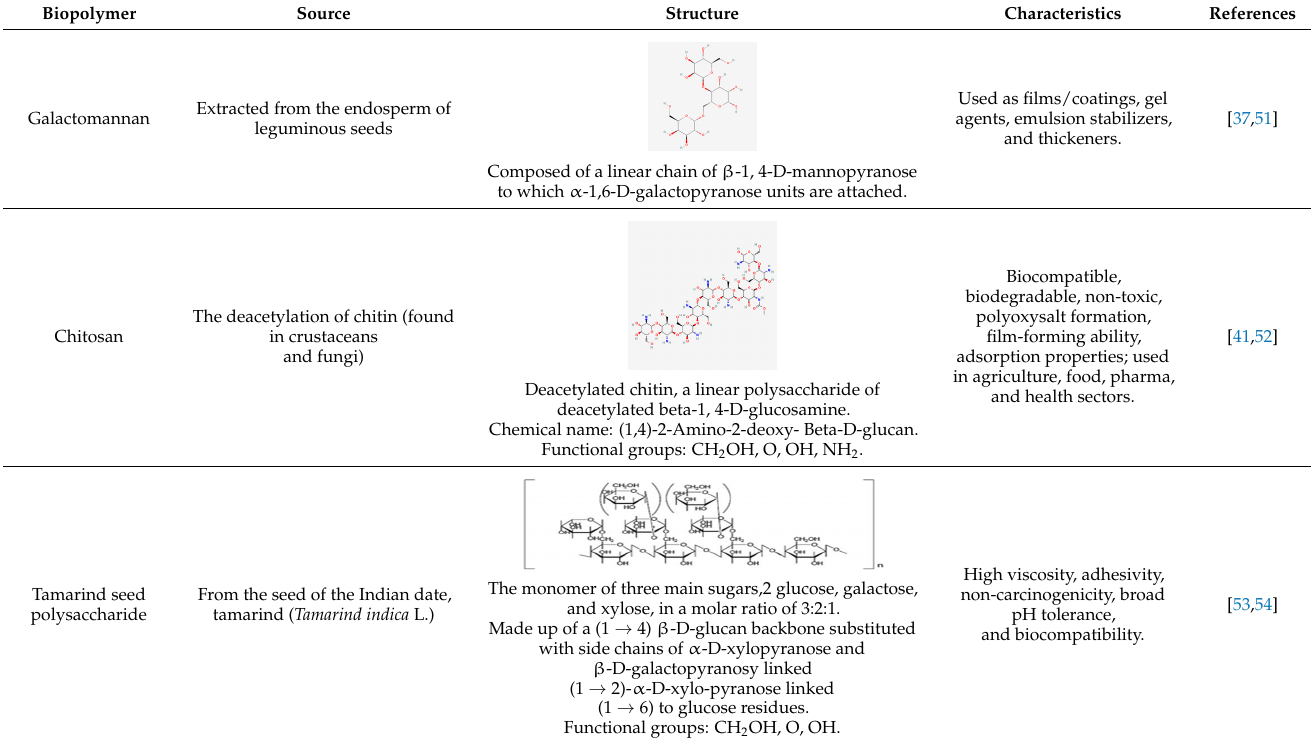
Table 1. Biopolymers used as nanoparticulate materials in agriculture and other fields: sources, structure, characteristics, and uses.